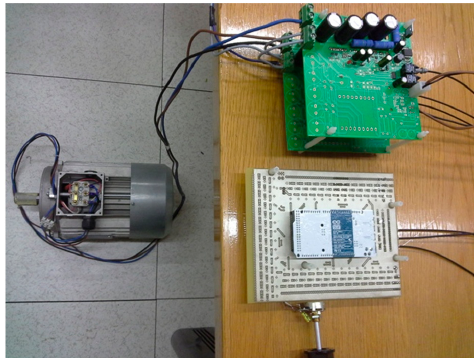
Figure 22. Experimental setup: Induction motor ( left ) supplied by three ‐ phase inverter ( top ) and microcontroller board ( bottom ).